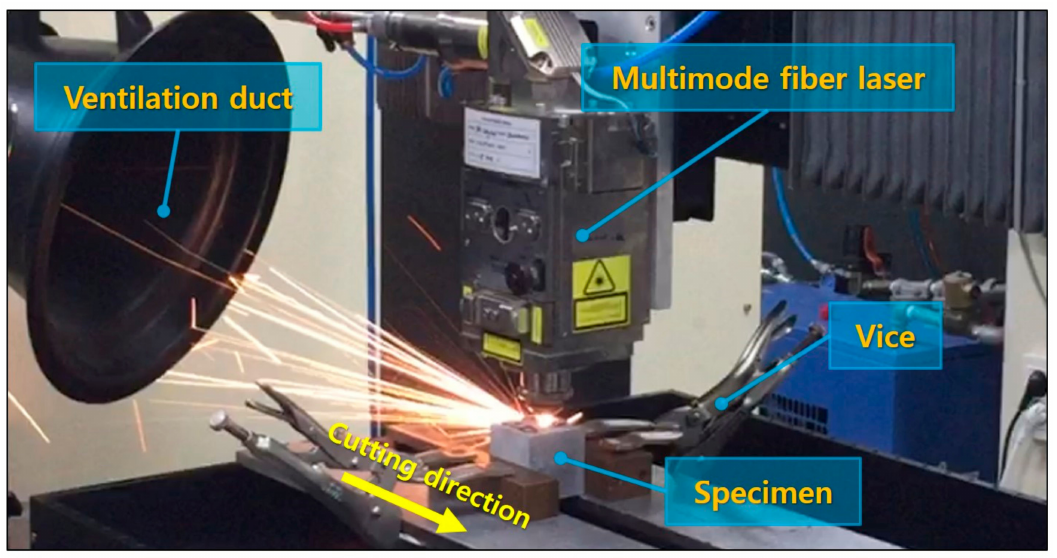
Figure 1. Experiment